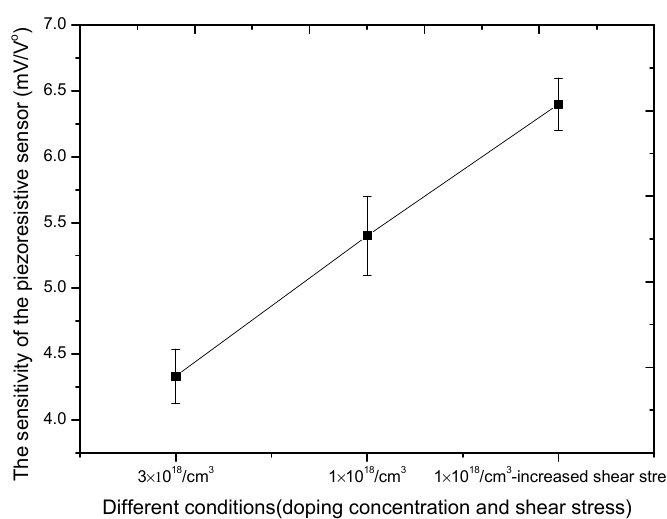
Figure 11. The sensitivity of the piezoresistive sensor increases with the change of piezoresistive coefficient and shear stress.